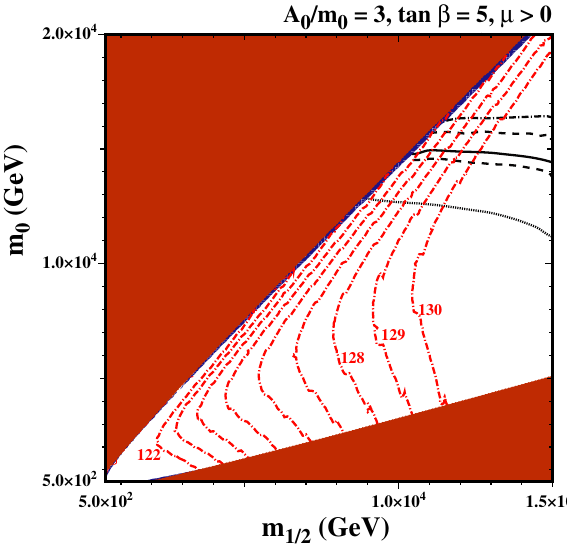
Fig. 5 Sensitivity of the p → K + ν lifetime calculation to m s for tan β = 5 , A 0 / m 0 = 3 , M in = M GUT and μ > 0. The dashed lines correspond to the variation of m s within one standard deviation ( m s = 93 + 11 − MeV) and the dotted line corresponds to the combined 5 uncertainty from the hadronic matrix elements and α s . The dot-dashed curveshowsthepositionofthelifetimelimitwhenthe1-loopcorrection to m s is removed